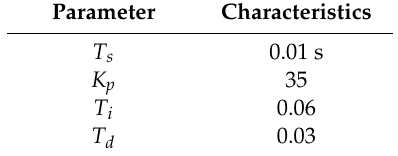
( b ) Figure A3 Animal test: ( a ) PaO 2 , PaCO 2 , and ETCO 2 ; ( b ) IPAP, EPAP, and FiO 2 . Once the distress was induced (Sample 3, Figure A3), the arterial oxygen pressure was drastically reduced (PaO 2 from 520 mmHg to 110 mmHg), while there was a considerable increase in the concentration of CO 2 in the blood and expired air (PaCO 2 from 42 mmHg to 75 mmHg and ETCO 2 from 47 mmHg to 59 mmHg), which reflects a reduction in the capacity of alveolar gas exchange and therefore lung degradation. To counteract this effect, ventilation with high FiO 2 levels and IPAP